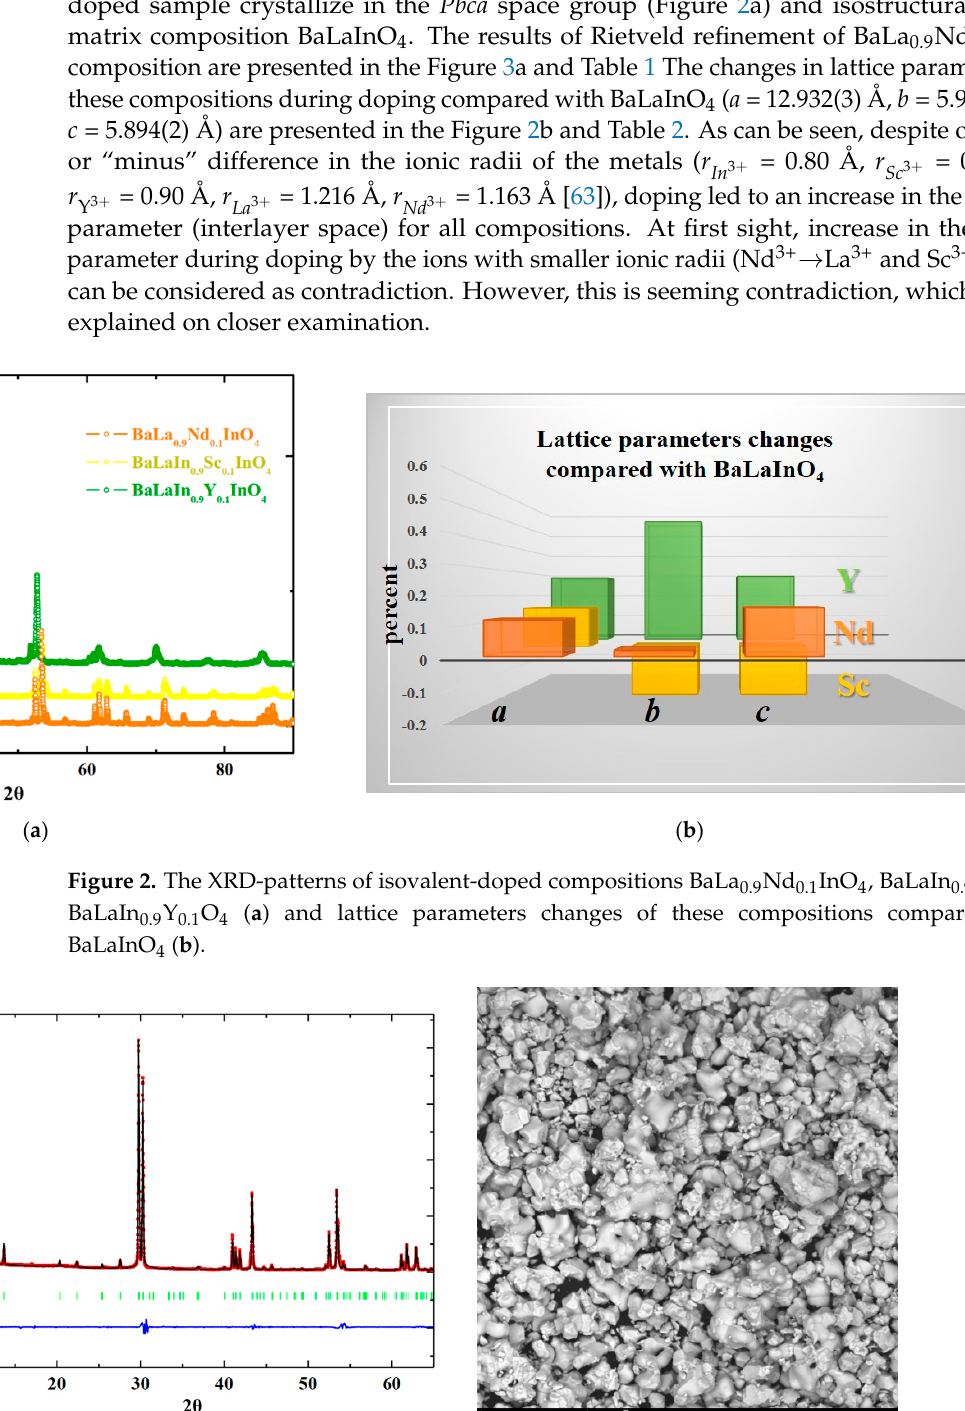
Table 1. Refined structural parameters from XRD-data.